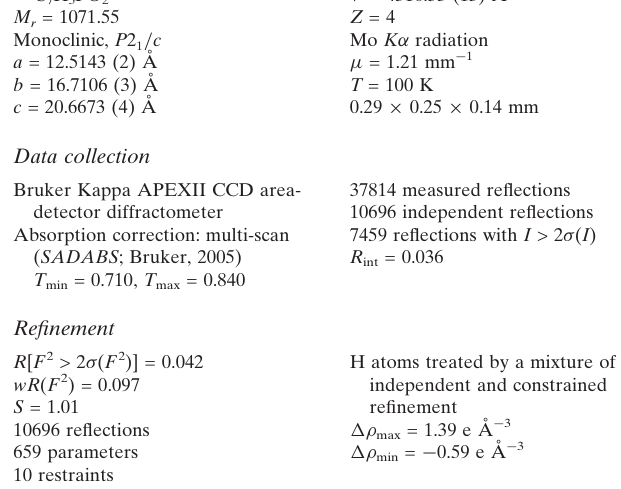
Data collection Bruker Kappa APEXII CCD area- detector diffractometer Absorption correction: multi-scan ( SADABS ; Bruker, 2005) T min = 0.710, T max = 0.840 (C H FO ) - 2 7 4 2 4 659 parameters 10 restraints Selected bond lengths (A˚ ). Hydrogen-bond geometry (A˚ , (cid:3) ). D —H (cid:2)(cid:2)(cid:2) A